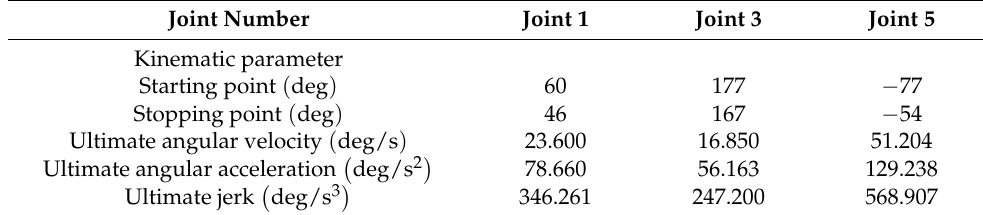
Table 4. Simulation result of joint motion